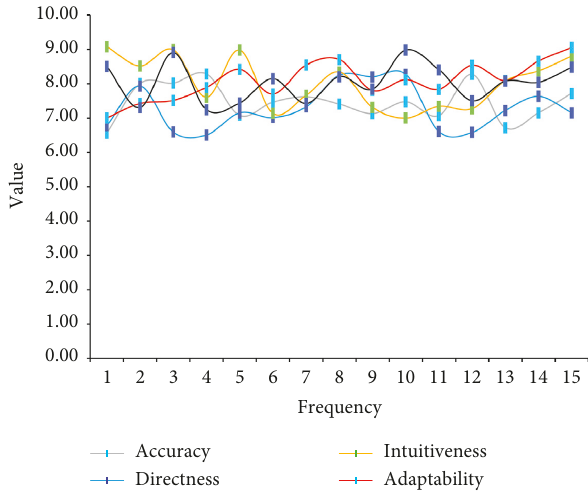
Figure 9: Machine vision image automatic measurement tech- nology-related